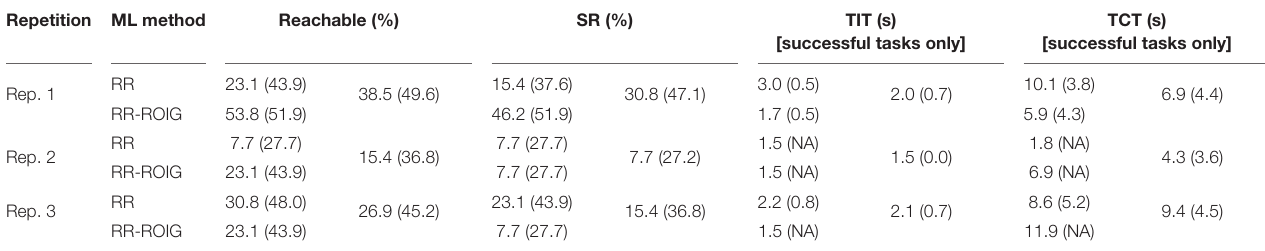
TABLE 4 | Means and standard deviations of the reachability of the tasks, the success rate, the time in task and the time to complete the successful tasks for the amputated subject according to the three repetitions of the task-reaching